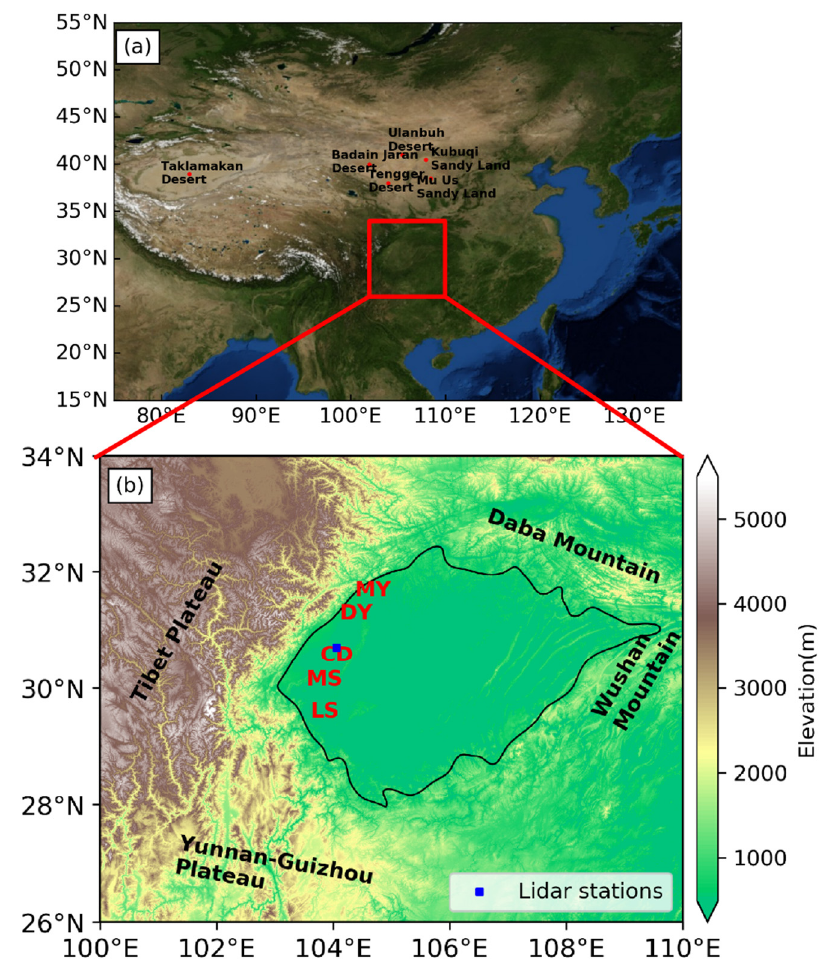
Figure 1. The geographical location ( a ) and topography ( b ) of the study area. The blue square marks the ground lidar station. The black line gives the isoline with a topographic elevation of 750 m above sea level. The city acronyms of MY, DY, CD, MS, and LS represent Mianyang, Deyang, Chengdu, Meishan, and Leshan, respectively.